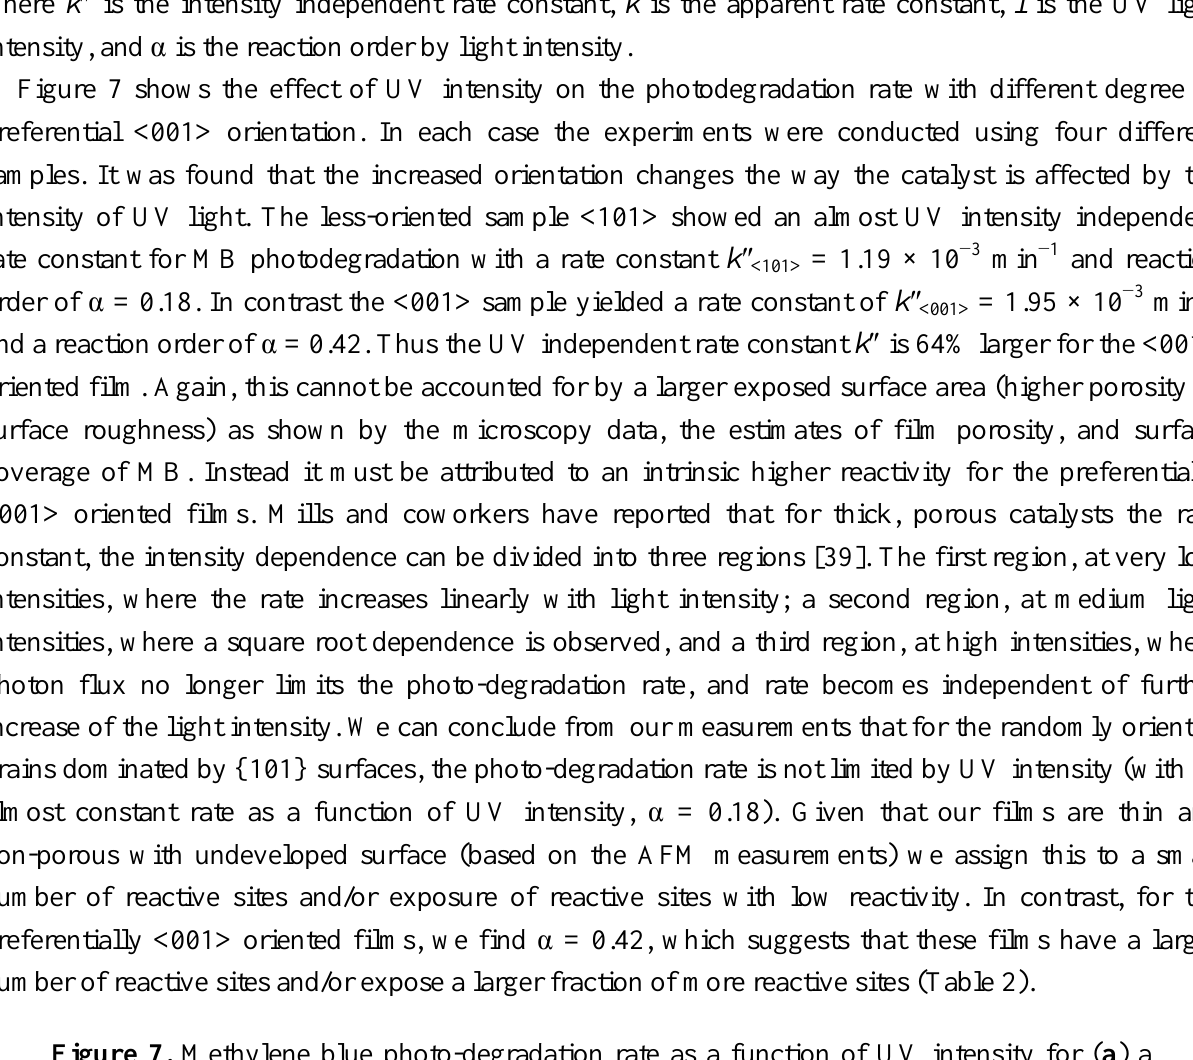
film, and ( b ) a preferentially <001> orientated TiO 2